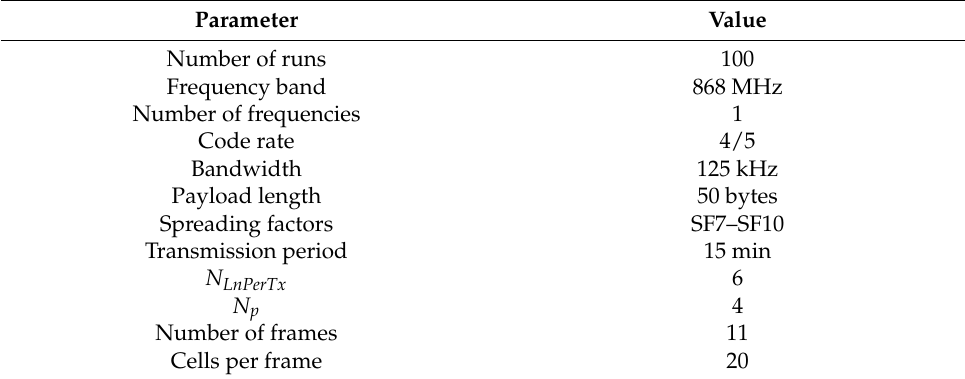
Table 5. Simulation parameters.